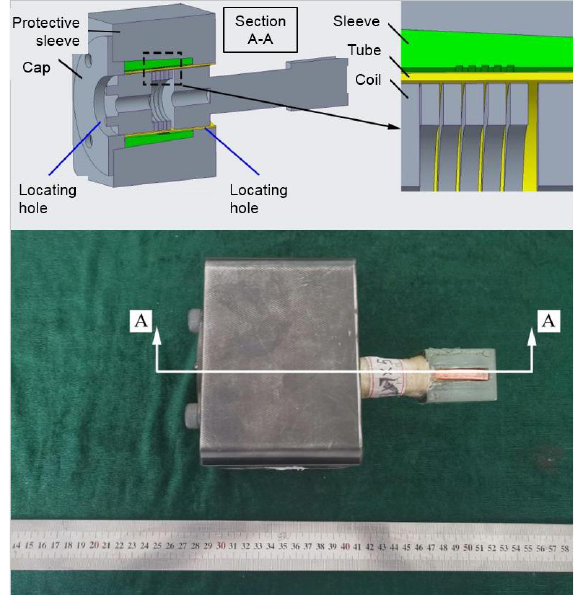
Figure 3. Experiment equipment and models. Table 2. Variable tube-tube sleeve initial gap and voltage process parameter settings.